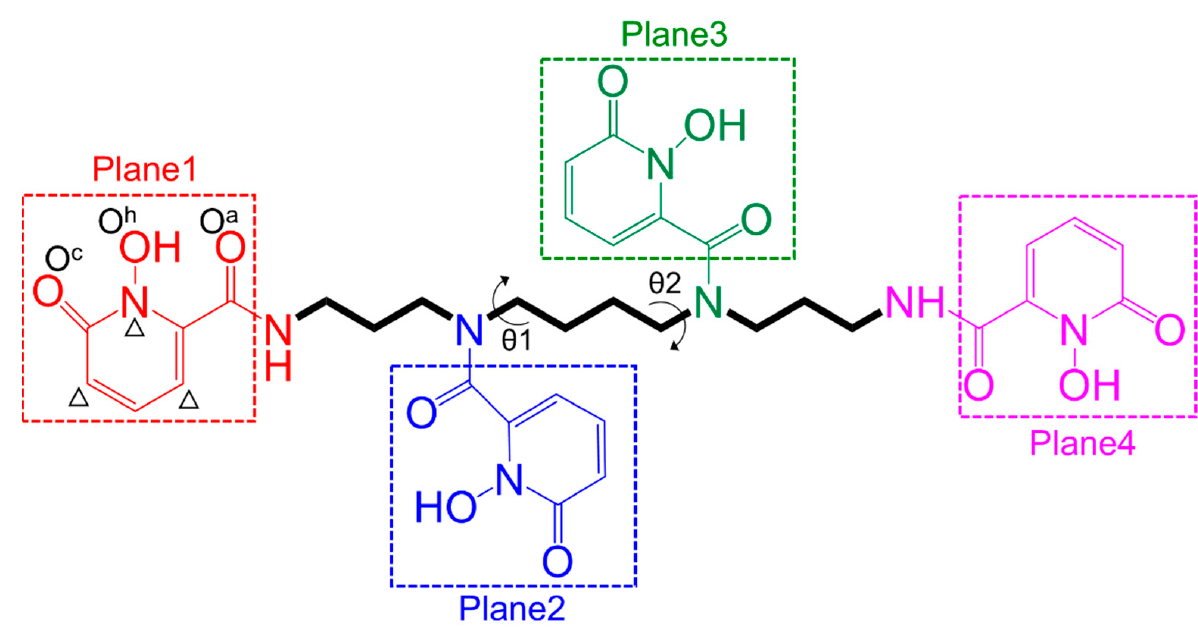
Scheme 1. Schematic elucidation of the structure of 3,4,3-LI(1,2-HOPO) (denoted as t- HOPO). The molecule is partitioned into a spermine chain and four 1-hydroxy-pyridin-2-one rings (denoted as m- HOPO; Plane1, Plane2, Plane3 and Plane4 highlighted in red, blue, green and pink, respectively).